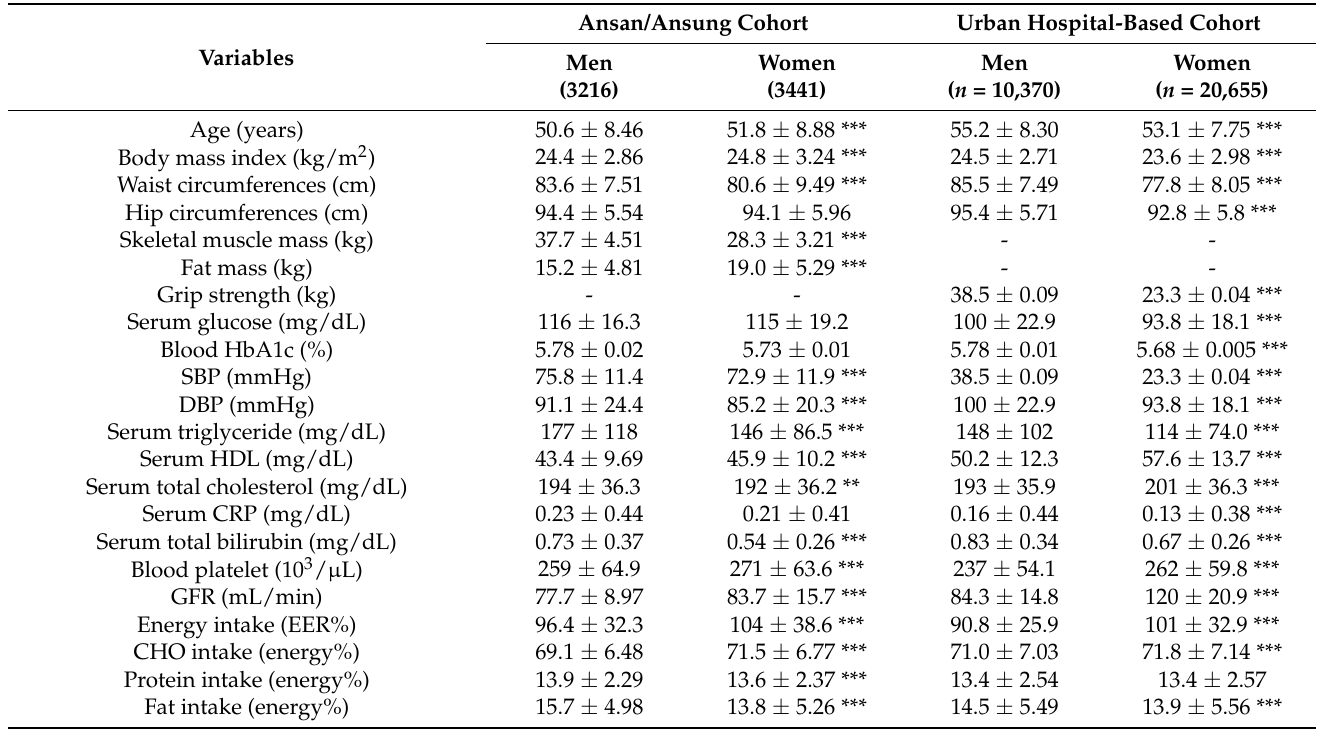
Table 1. The characteristics of participants according to the genders in the Ansan/Ansung and urban hospital-based cohorts.